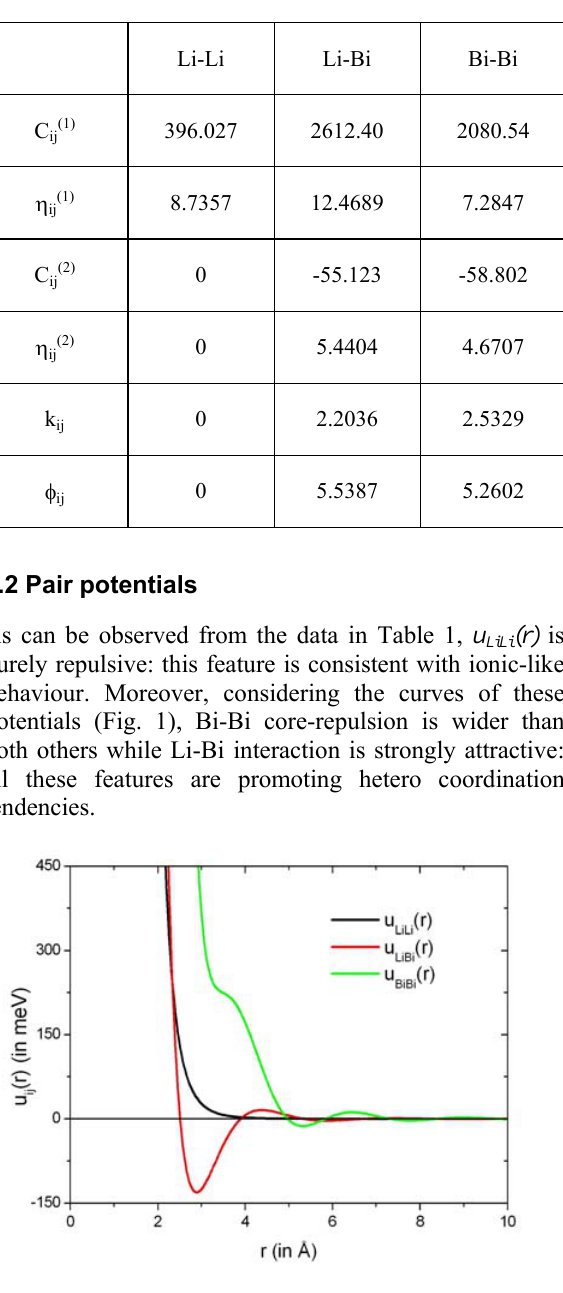
Fig. 1. Effective pair potentials fitted to ab-initio simulations.